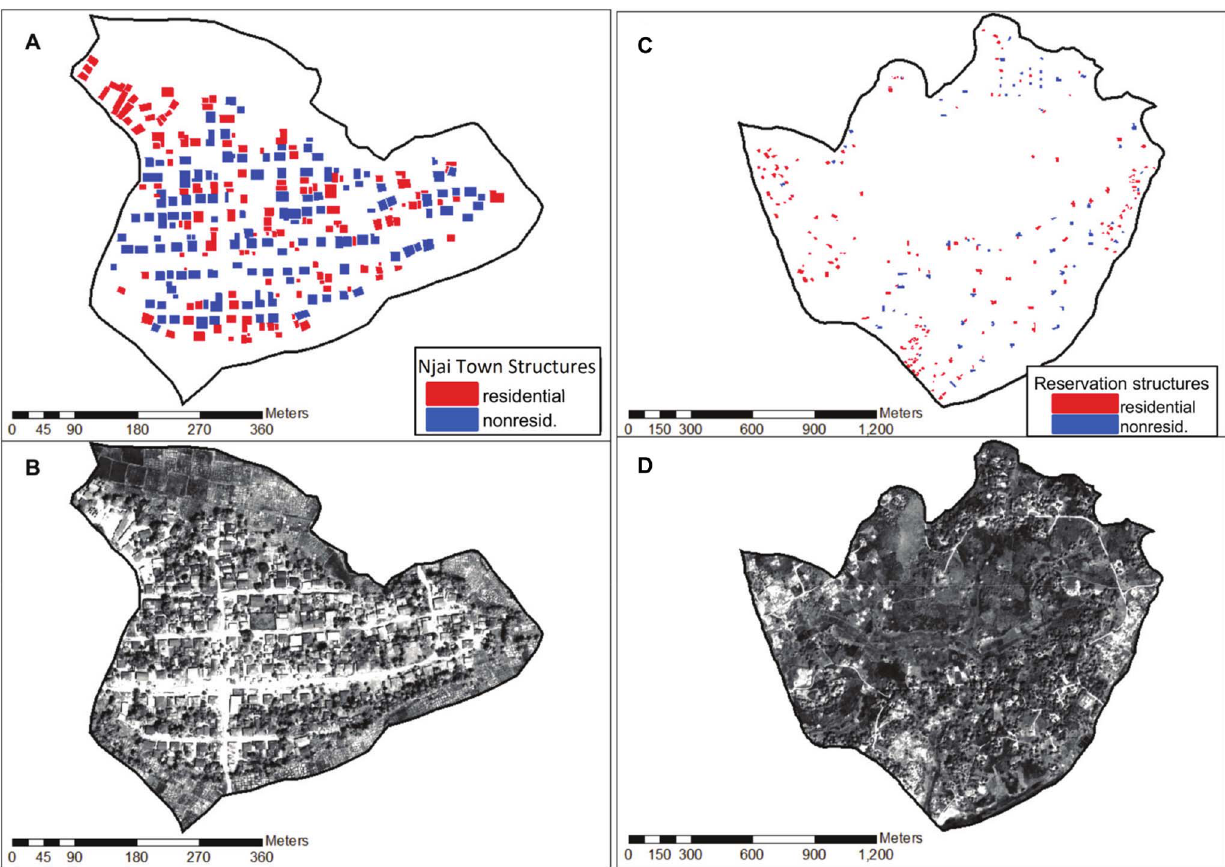
Figure 6. Residential and non-residential structures in Njai Town and Reservation. (A) Njai Town residence structures (blue) and non- residential structures (red), (B) Njai Town satellite imagery, (C) Reservation residential structures (blue) and non-residential structures (red), and (D) Reservation satellite imagery. When comparing either the maps or imagery for Njai Town and Reservation, note the differences in the map scales, which create the illusion that the structures in Reservation are smaller, although the average residential rooftop area in Reservation (255 m 2 ) is actually greater than that of Njai Town (172 m 2 ). The total land areas for Njai Town and Reservation are 0.21 km 2 and 2.33 km 2 , respectively. (Image copyright 2010 DigitalGlobe NextView License. Used with